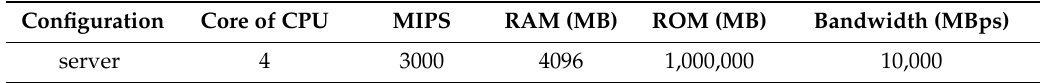
Table 1. Physical server configuration information.